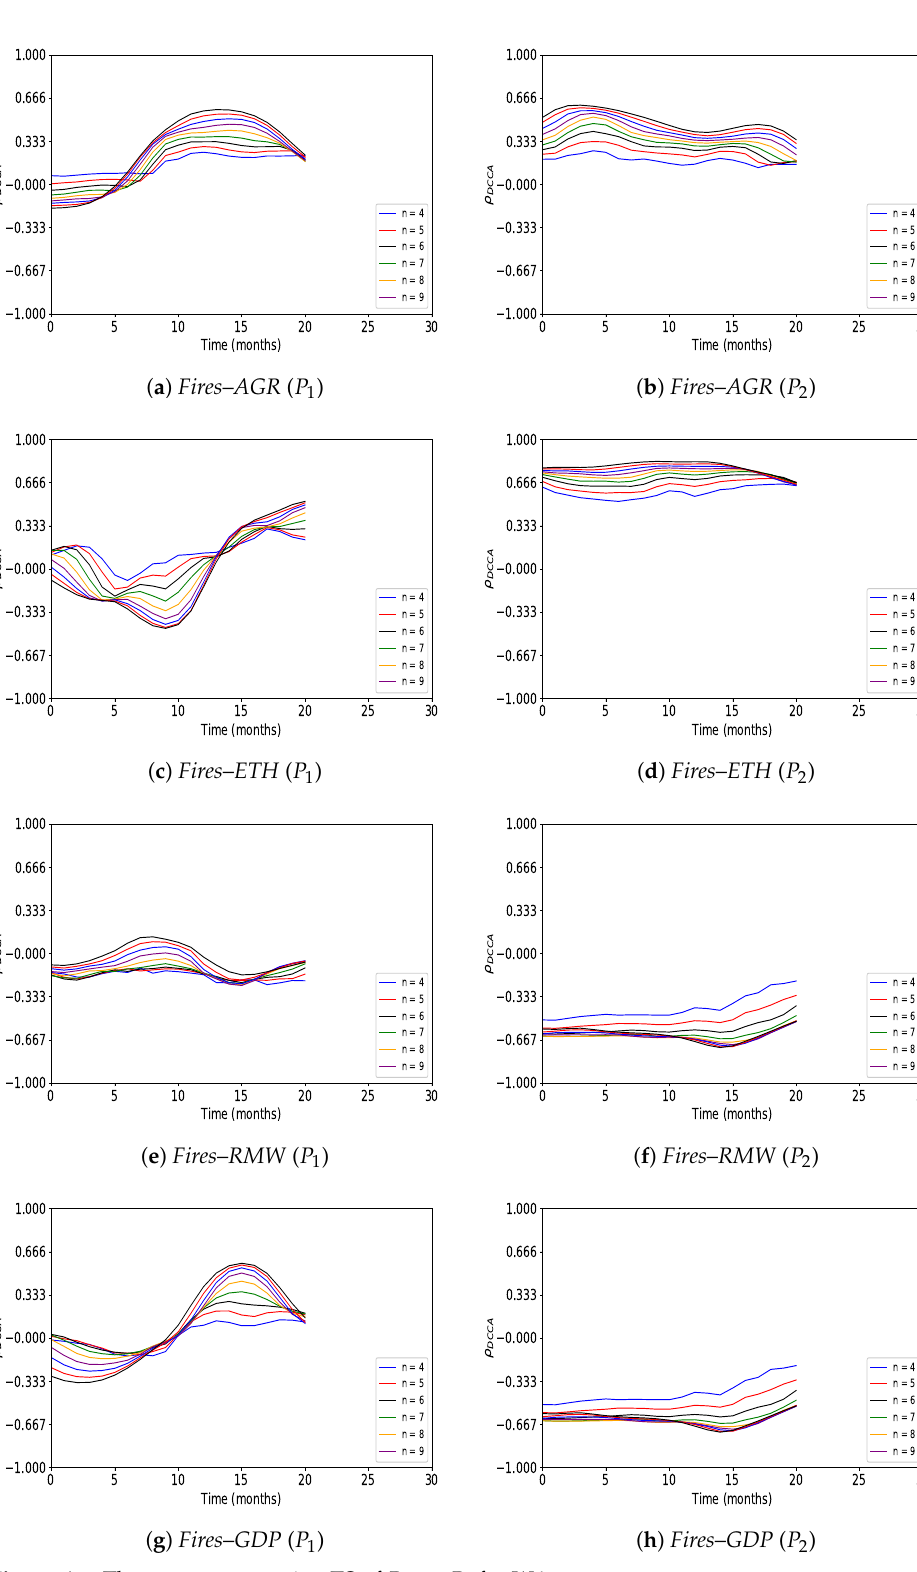
Figure A3. The ρ DCCA comparing TS of P 1 vs. P 2 for